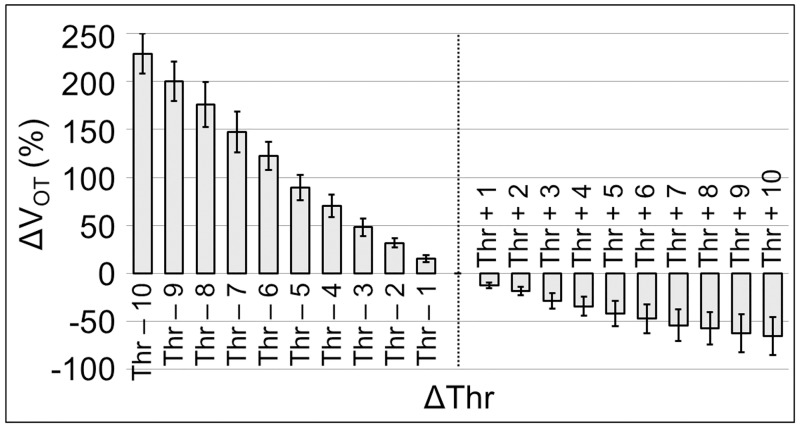
Sensitivity analysis of the threshold method.Volumes (n = 22) are expressed as percentage variation with respect to the volume obtained with the optimal threshold Thr (dashed line).